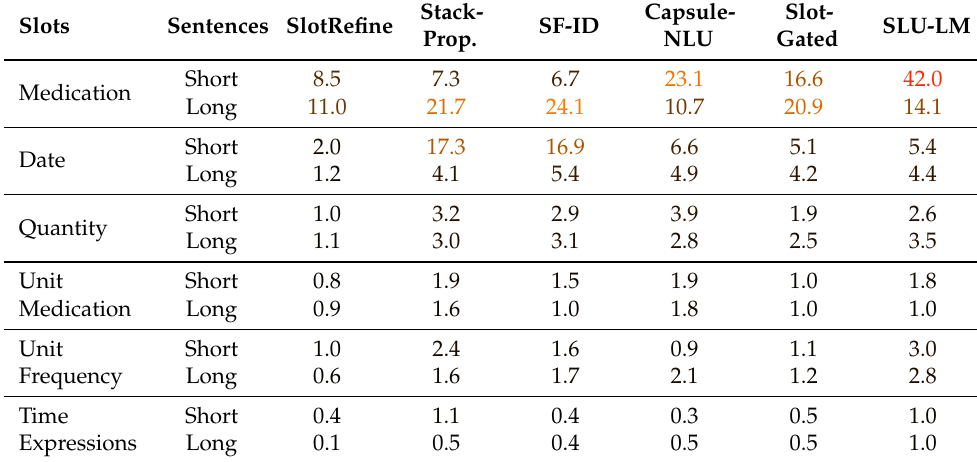
Table 7. Errors in slot tagging for short slots (in